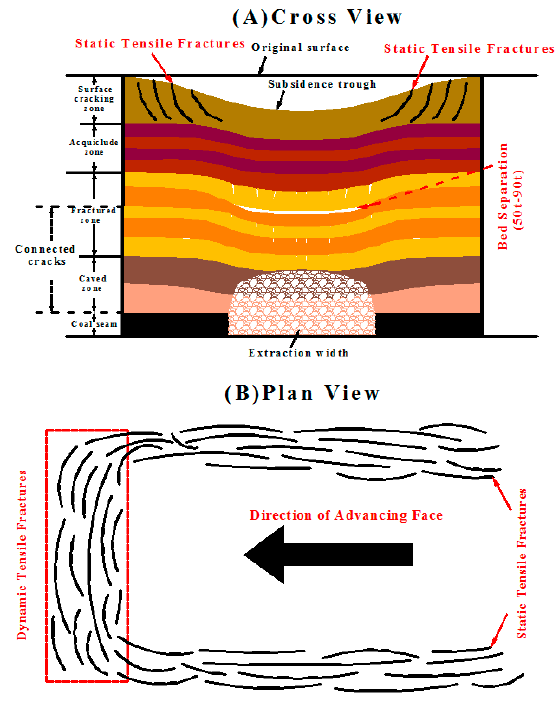
Figure 2. Schematic view illustrating the mining-induced fracture system. ( A ) Cross review; ( B ) Plan review.